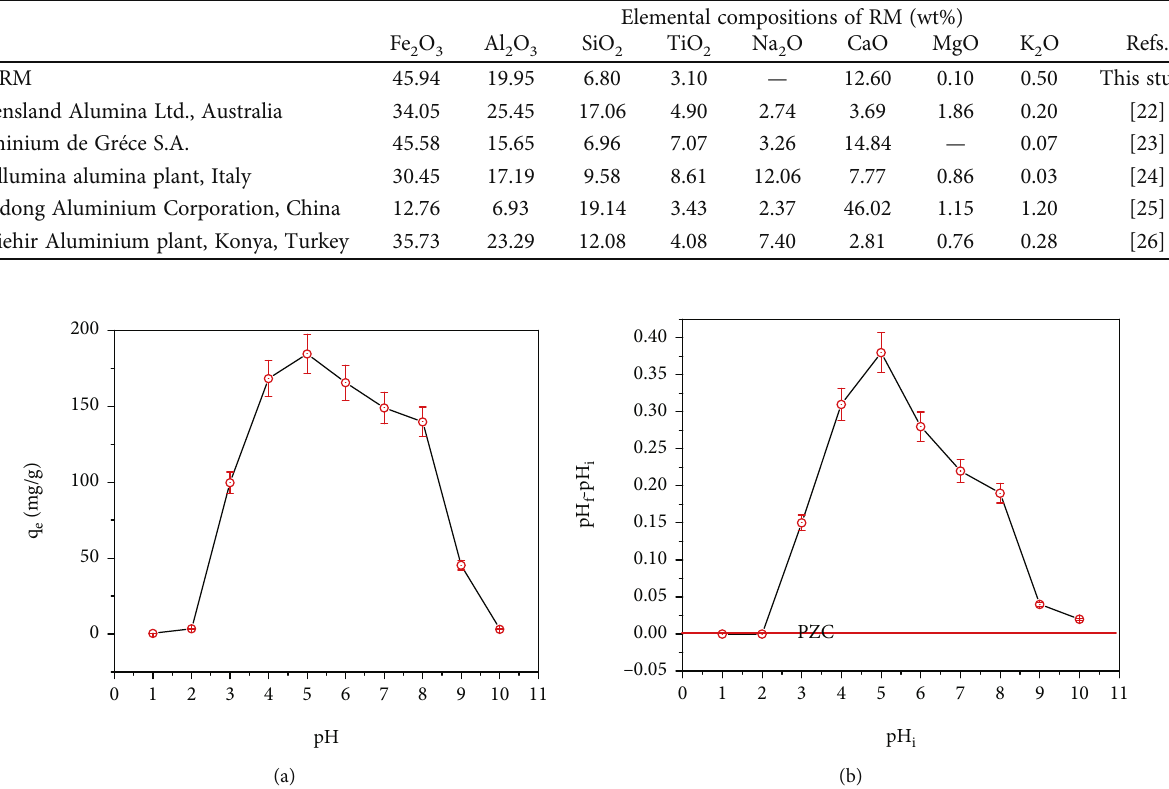
Figure 6: (a) Phosphorus adsorbed by M-ARM material at various initial pH conditions. (b) The plot of the variation in Δ pH = pH with pH . i